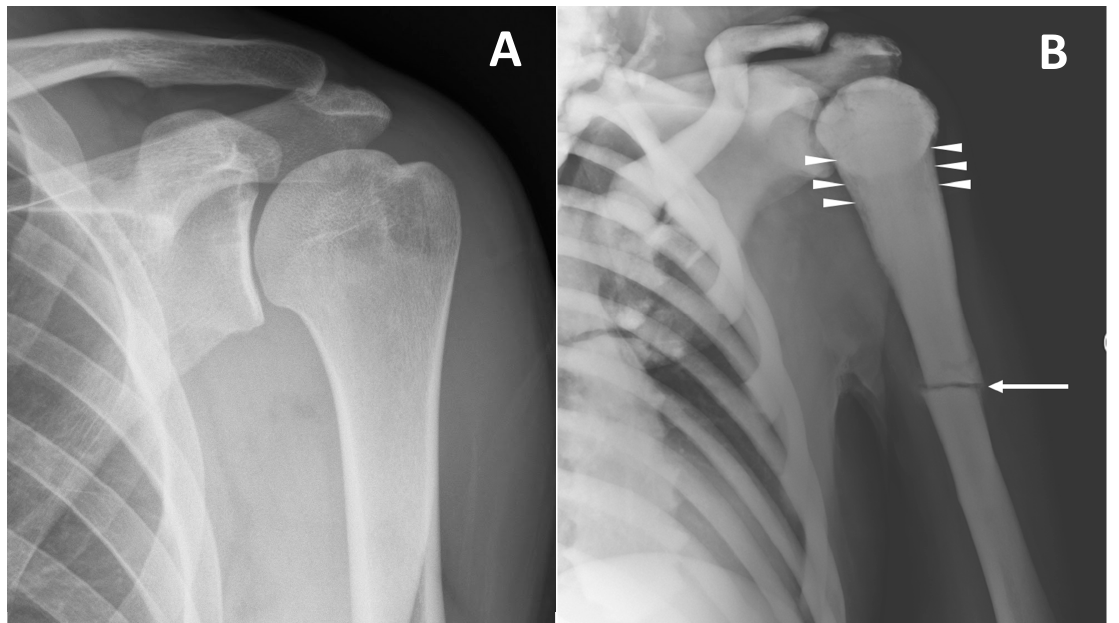
Figure 5. ( A ) conventional radiography of the left shoulder in a young healthy male (shown as comparison). ( B ) conventional radiography of a 45-year-old male with ARO type of osteopetrosis presenting with atraumatic pathological fracture of the diaphysis of the left humerus (arrow). A mild alteration of proximal metaphysis shape (arrowheads), and a diffuse increase in bone density of all the skeletal sites included can also be detected.